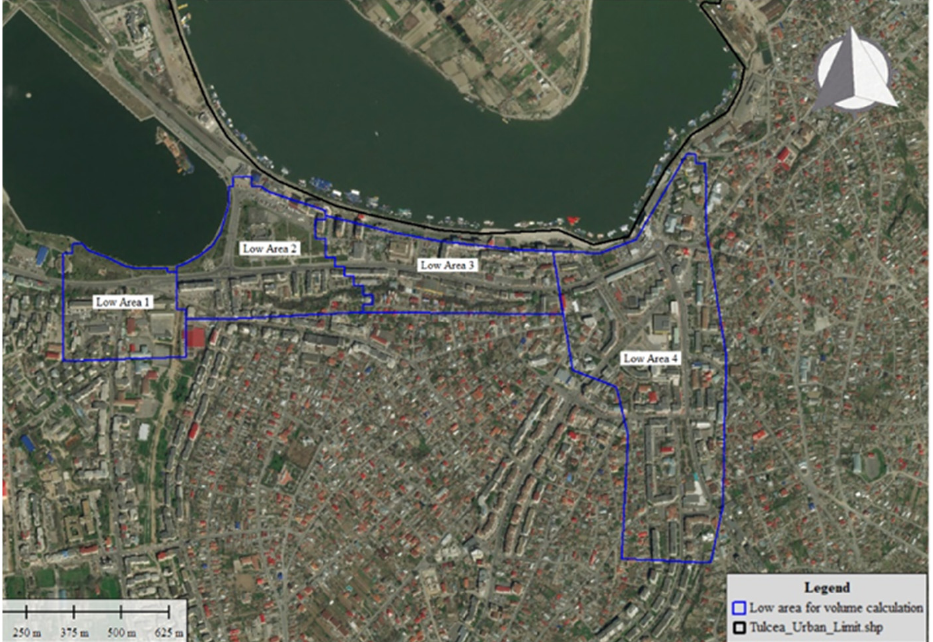
Figure 13. Location of the flood areas (cells).